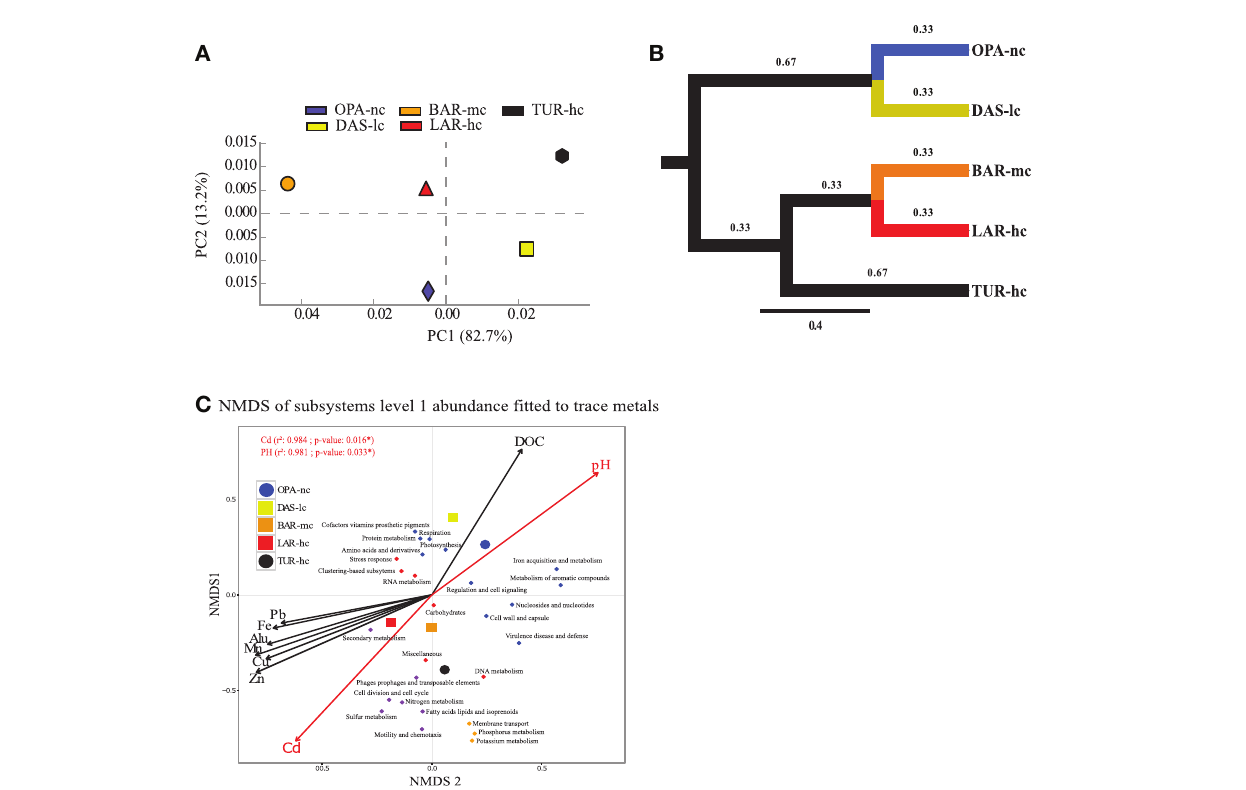
FIGURE 3 | Function abundance classification based on ORF approach. Composition analysis of metacommunity functions based on relative abundance (RA) of subsystems using principal component analysis (PCA) (A) , tree based Unifrac distance (B) and NMDS (C) identified the same pattern. (A) PCA figure was obtained from STAMP software (Parks et al., 2014). (B) NMDS (three a priori predefined dimensions projected into two dimensions, stress value < 0.05, Bray–Curtis distance) axes of all annotated subsystems level 1 fit significantly with Cadmium (Cd), and pH using the ORF approach. In d, each small dot represents a subsystem, while the large dot does represent the lake metagenome indicated with a circle for the negative control lake (OPA-nc) in blue and the positive control lake (TUR-hc) in black. The connected lakes are illustrated with squares (LAR-hc in red, BAR-mc in orange and DAS-lc in yellow). NMDS loadings (NMDS1, NMDS2), and P -value of correlation r 2 of trace metals were reported in Supplementary File S6 . Subsystems plot coordinates, clusters, and dot labels are resumed in Supplementary File S4 . (C) Tree based Unifrac distance computed with mothur is indicated by branch lengths In the ORF based approach the following parameters were strictly respected; 85% identity threshold, e -value of 10 − 12 , minimum alignment length of 50 base pairs, and the lowest common ancestor (LCA) algorithm for taxonomic assignment. OPA-nc (Opasatica Lake) is the negative control; DAS-lc (Dasserat Lake) is low polluted; BAR-mc (Arnoux Bay) is medium polluted; LAR-hc (Arnoux Lake) is highly polluted, and TUR-hc (Turcotte Lake) is the positive control of